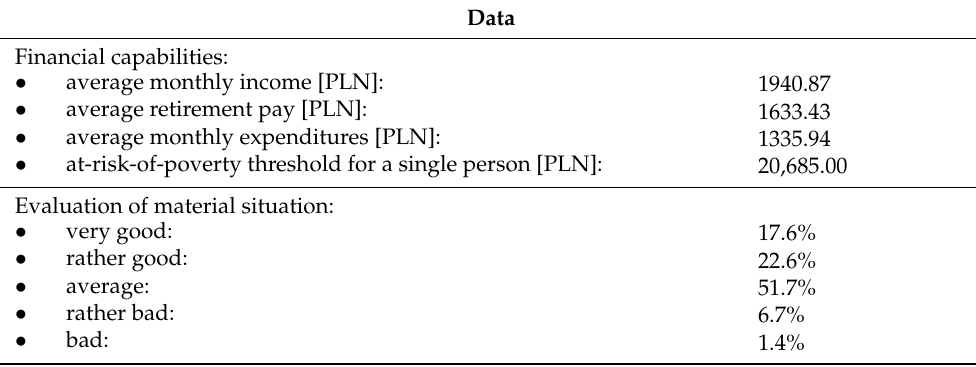
Table 8. Economic profile of a Polish senior. Source: own elaboration on the basis of [90–101].